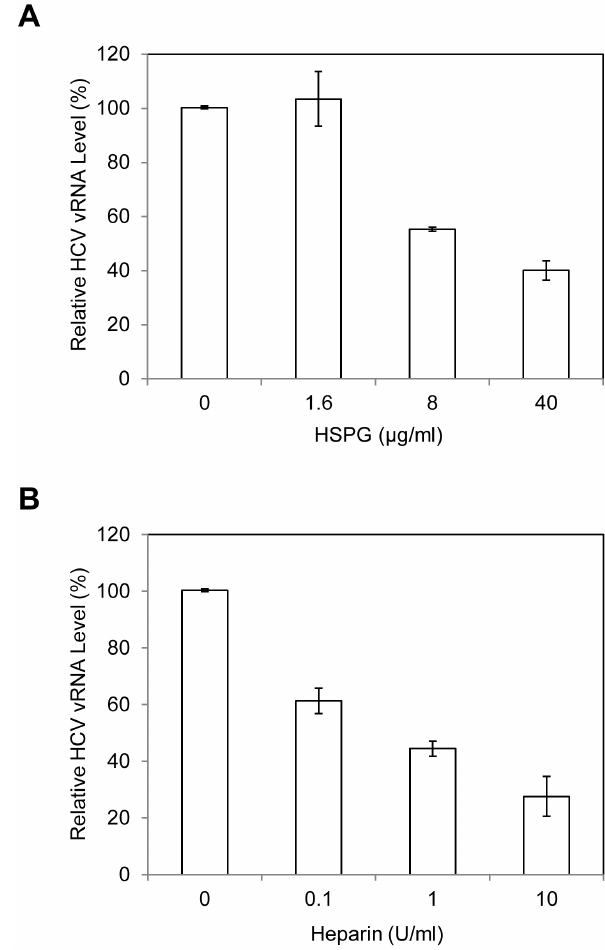
Figure 2. Inhibition of HCV1b attachment to DHHs by purified HSPG (A) and Heparin (B). The HCV1b was pre-incubated with varying amounts of HSPG or Heparin for 1 hr on ice prior to adding to day-11 DHHs in 12-well cell culture plates as described in materials and methods. After incubation on ice for 2 hrs, the unbound HCV was removed by washing cells with PBS for three times. The vRNA of the cell-bound HCV was extracted with Trizol reagent (Invitrogen). The levels of HCV1b vRNA were determined using the same real-time RT- qPCR method as in Fig. 1.